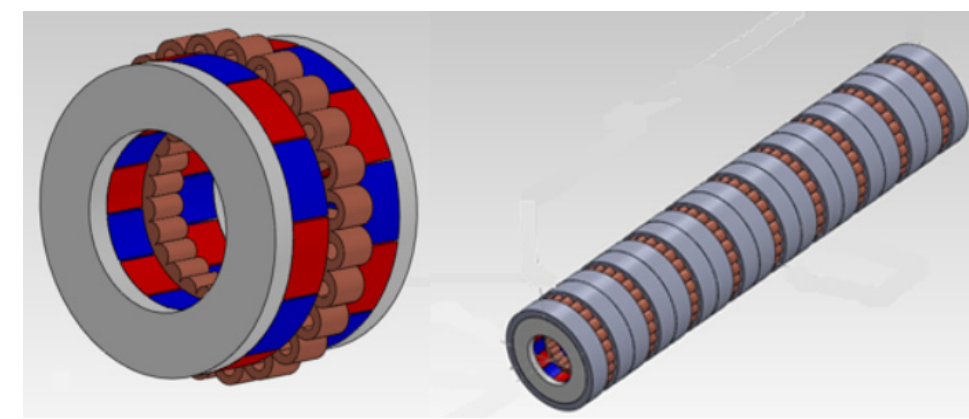
Figure 3. Construction of a single section and the entire generator assembled from